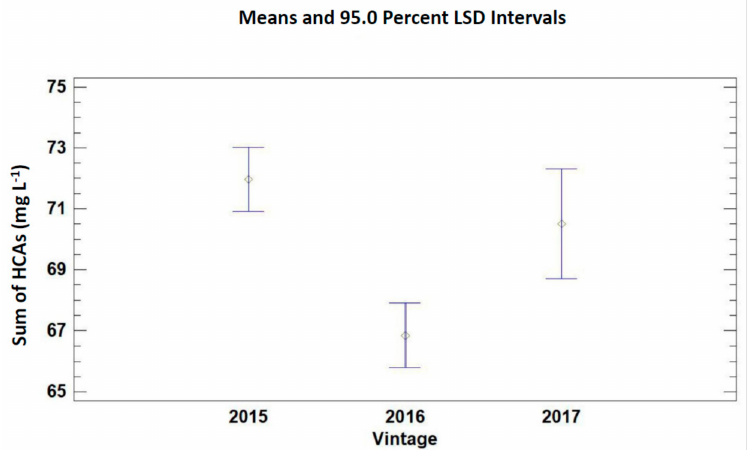
Figure 8. Significant differences between the sum of the hydroxycinnamic acids (HCAs) in wine and vintages in all variants and varieties.